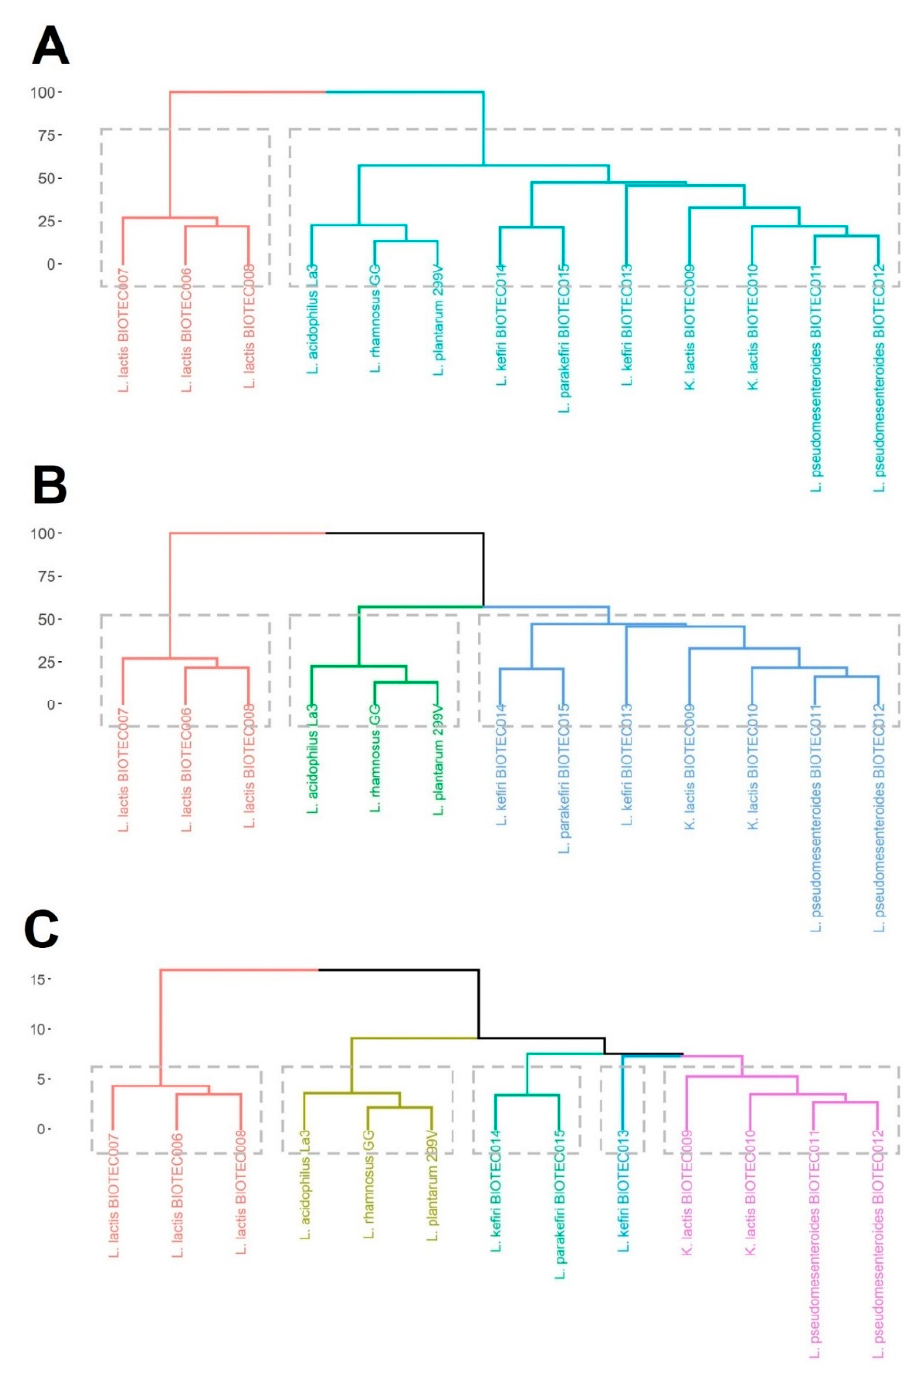
Figure 3. Cluster analysis of the kefir isolates and commercial probiotics. The differences were computed as dissimilarities, and all measured data from the different tests performed were used as input variables. The dashed line was used to represent the cut-off point grouping statistical clusters by using a linkage distance (Dlink/Dmax) × 100 < 60 ( A ), < 45 ( B ), and < 40 ( C ).